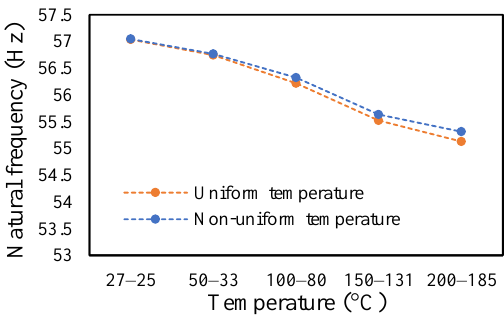
Figure 21. Comparison of natural frequency of 0.5 mm crack depth ramped at 2 °C/min.